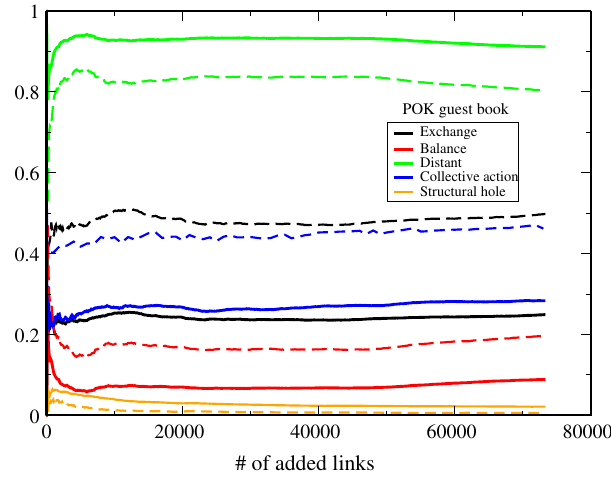
FIG. 7. Comparison of the probabilistic tendencies fraction, where links are characterized either at the time of addition (solid lines) or at the time of observation (dashed lines) in the POK community.